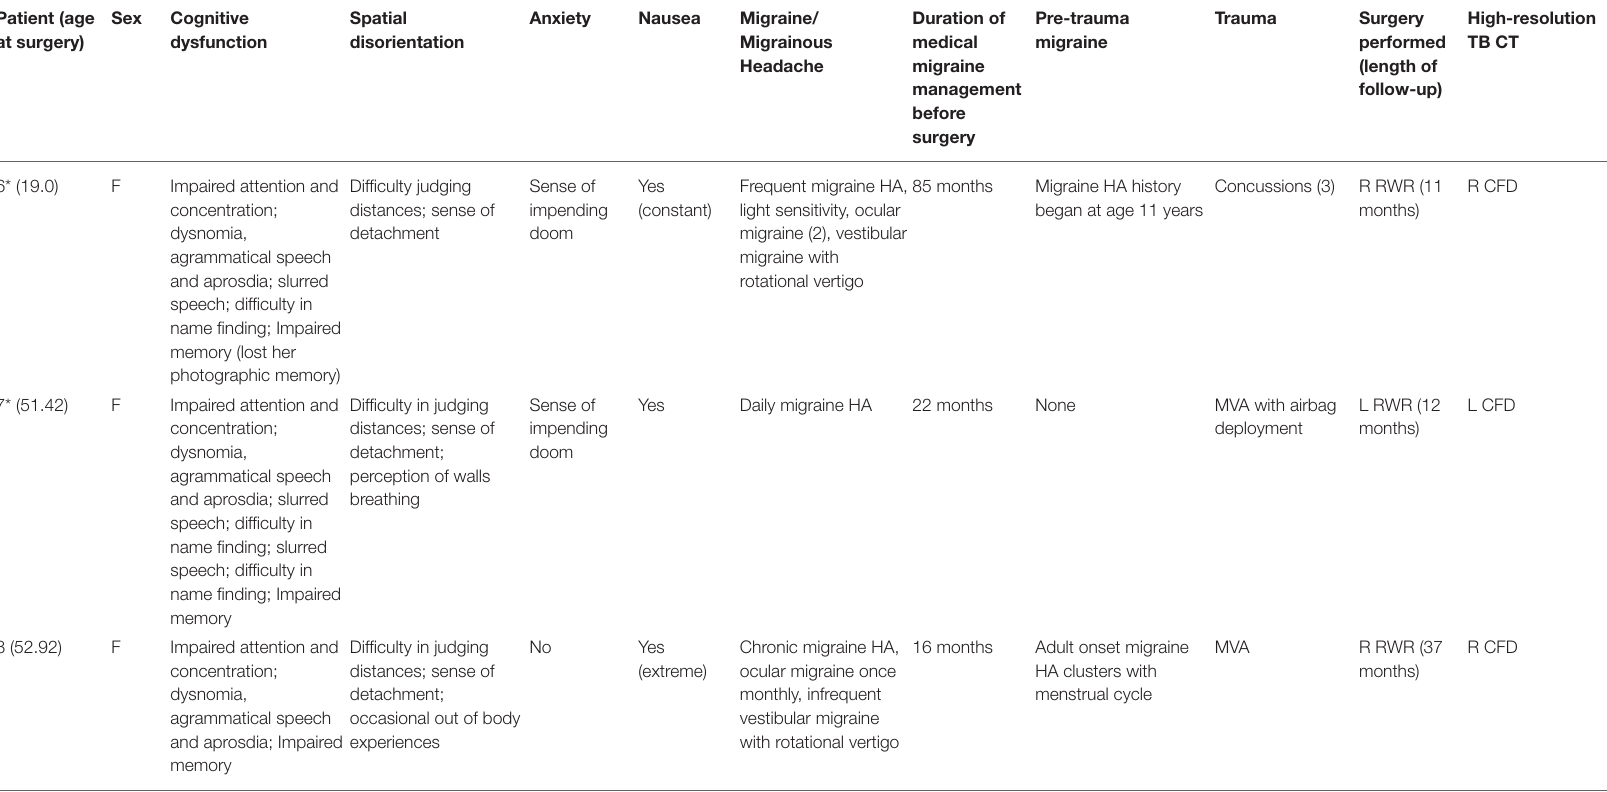
Group 1: Cochlea-facial nerve dehiscence and third window syndrome patients who underwent round window reinforcement